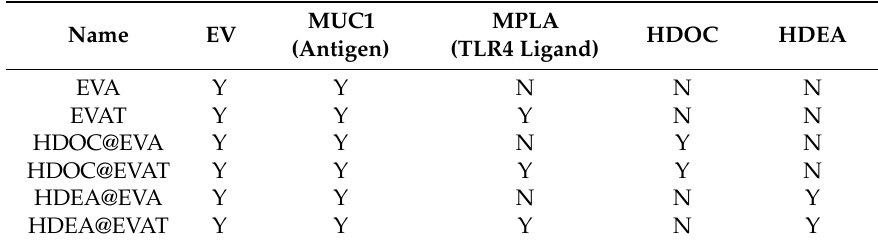
Table 1. Components of used particles. Y indicates the presence and N indicates the absence of these